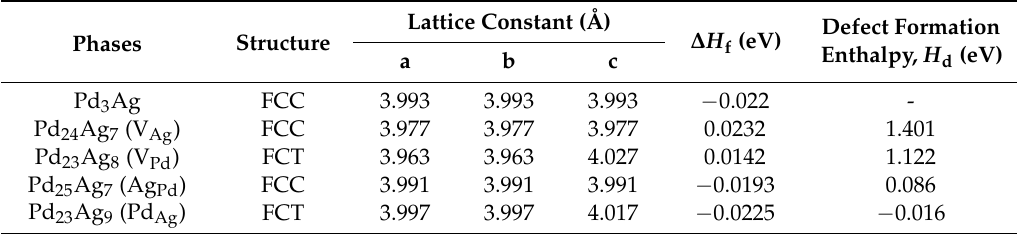
Table 2. Structure, lattice constants ( a ), and formation enthalpy ( ∆ H f ) of Pd 3 Ag with and without a single point defect. The corresponding four kinds of defect formation enthalpy ( H d ) werealso derived and are listed for comparison.